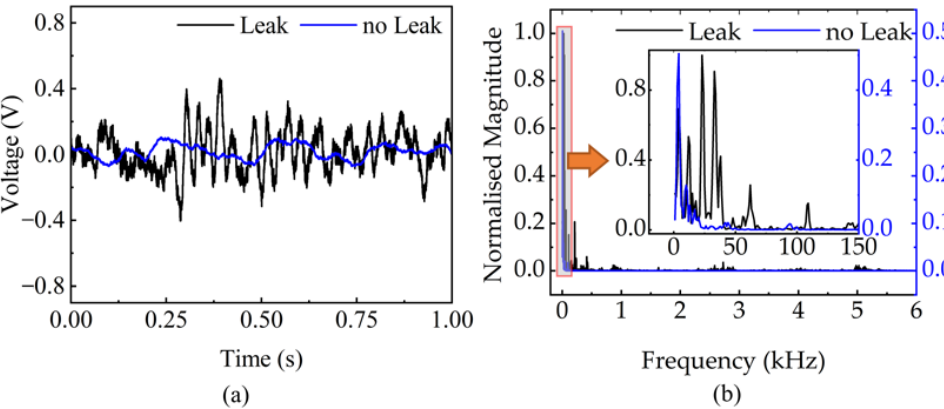
Figure 7. Time domain and normalized frequency domain plots of a 158 Hz acoustic signal: ( a ) Time domain plot of the two hydrophones, ( b ) Normalized frequency domain plot of the two hydrophones.